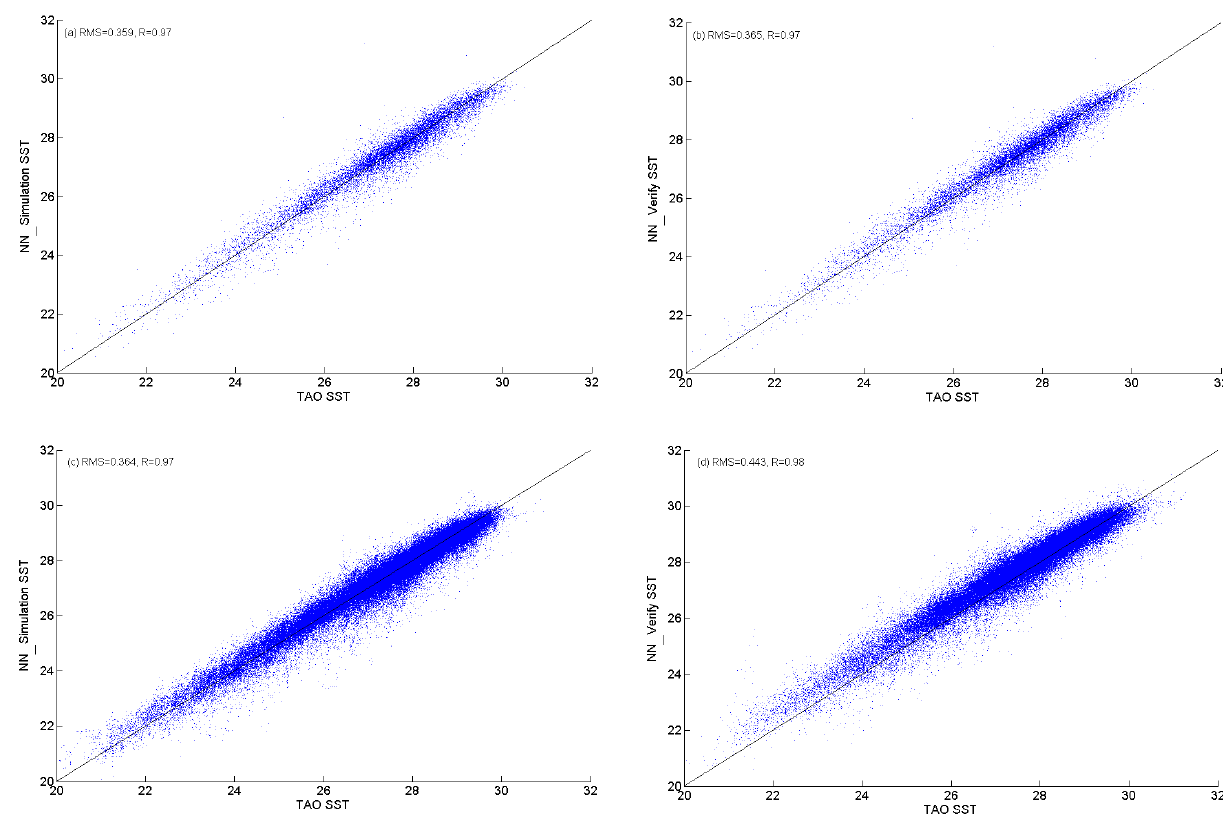
Figure 5. Scatter-plot of daily verification data and hourly verification data with in situ